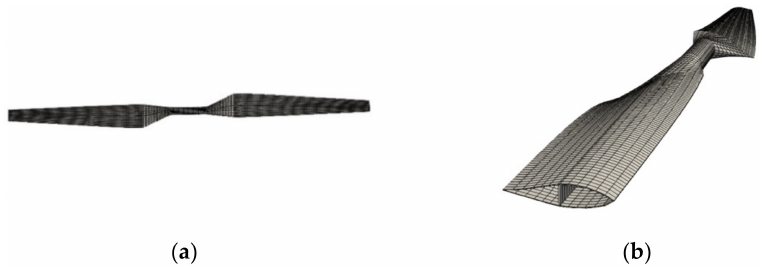
Figure 3. The mesh generated for the solid blade, which includes the D-cap and trailing edge with the 29,446 structural mesh cells in number: ( a ) Blade solid mesh; ( b ) Blade solid mesh internal